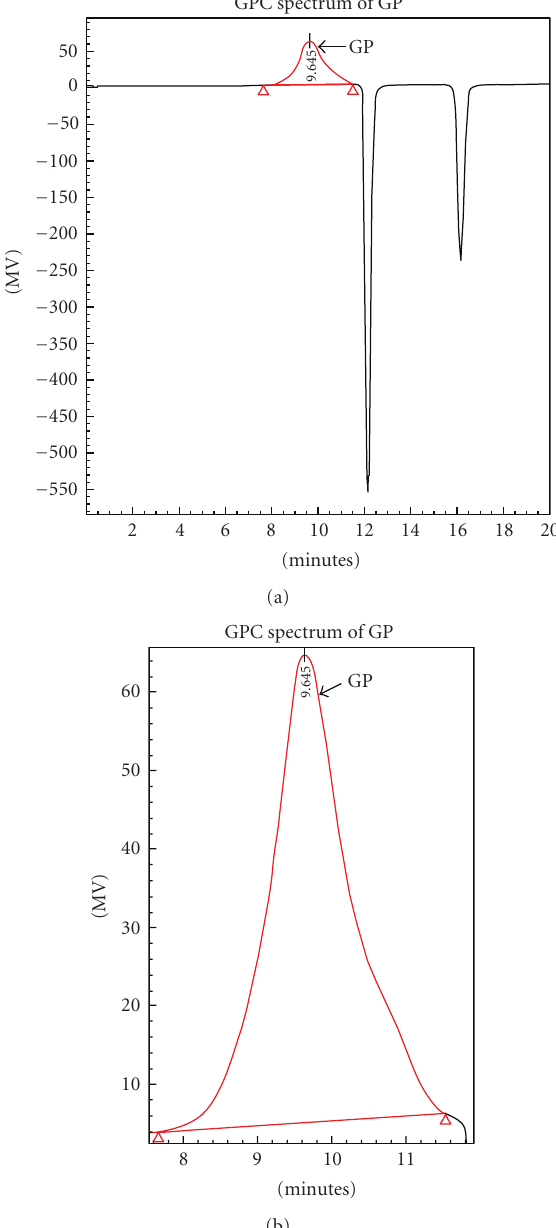
Figure 2: Gel permeation chromatogram (GPC) analysis of GP showed the purity of GP was greater than 95%. The spectrum showed the retention time of9.645minand the estimated molecular weight of 7,484.